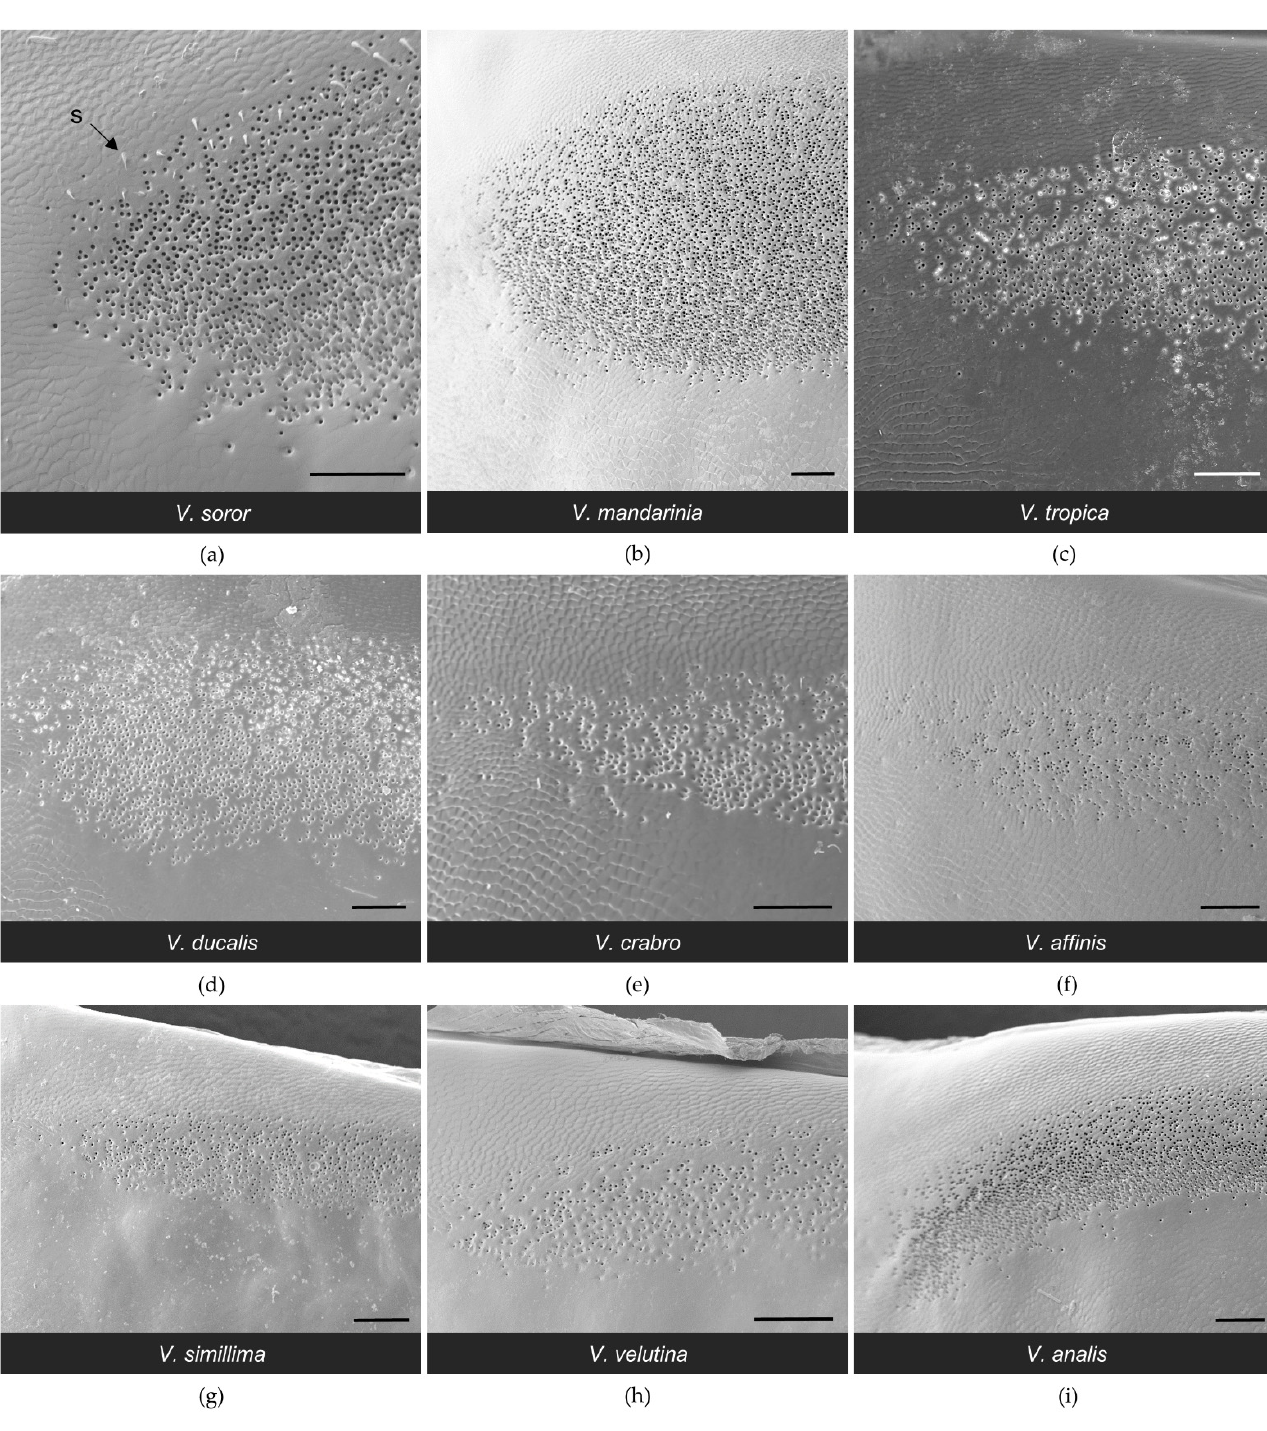
Figure 8. SEM images of nine Vespa species ( a – i ) showing the lateral margin of the band of pores of the Richards gland. Anterior is at the top. Species are presented in the order in which they appear in the phylogeny depicted in Figure 1. Bars indicate 100 μ m for scale; s = seta.